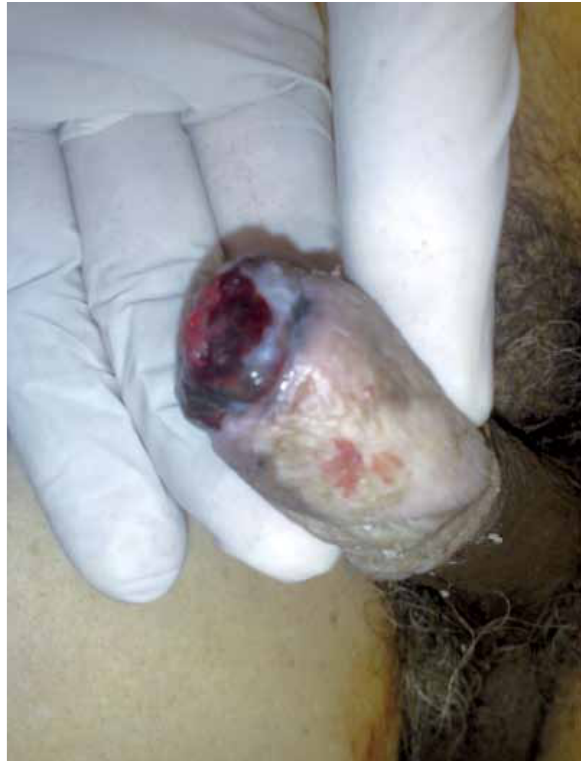
poorly defined borders, located in and around the glans meatus, measuring approximately 3.0